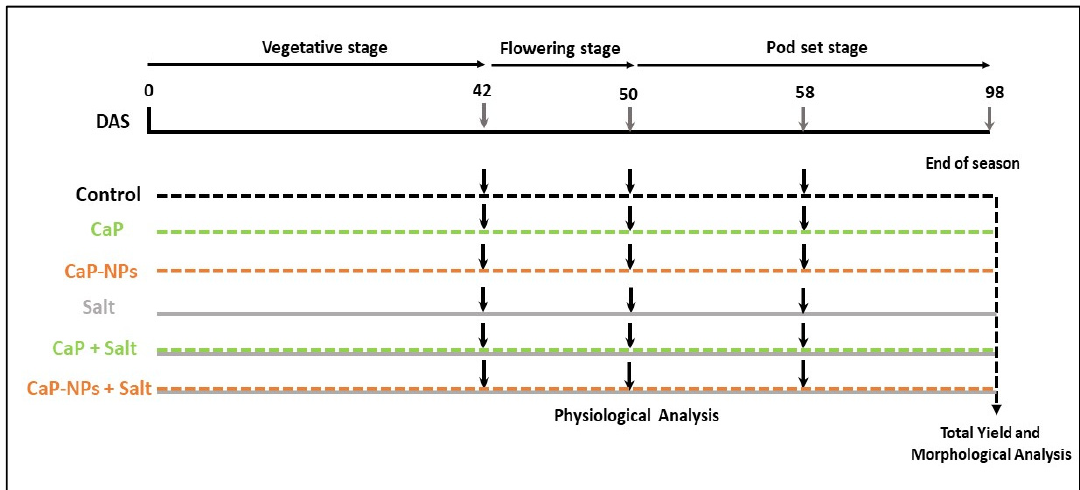
Figure 2. Scheme of the experimental setup. Horizontal lines represent different plant treatments: control, CaP, CaP-NPs, Salt, CaP-NPs + Salt, and CaP + Salt. Broad bean yield was harvested at the end of the experiment.